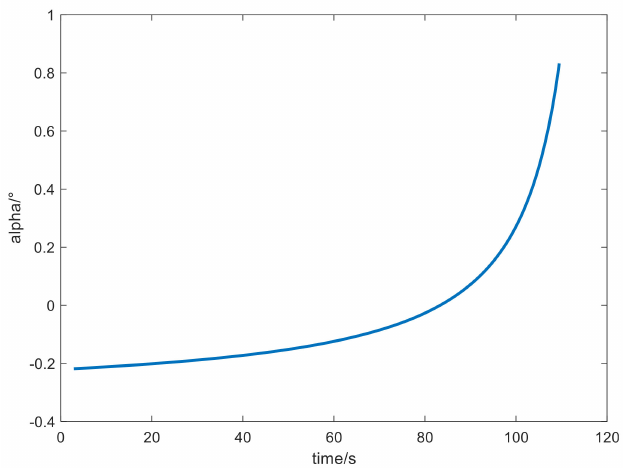
Figure 24. Calculated angle of attack